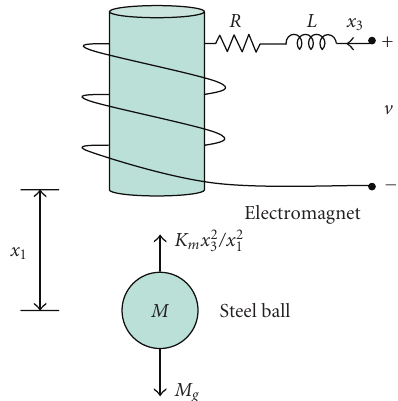
Figure 2: Block diagram of the FPGA